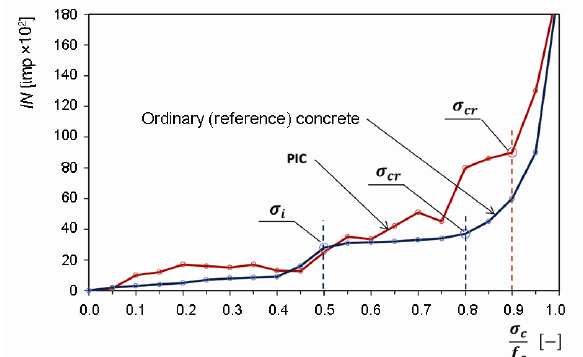
Fig. 3. Rate of AE counts sum increment in PIC and in reference unimpregnated concrete, under compression, versus increment in relative stress value (Hoła